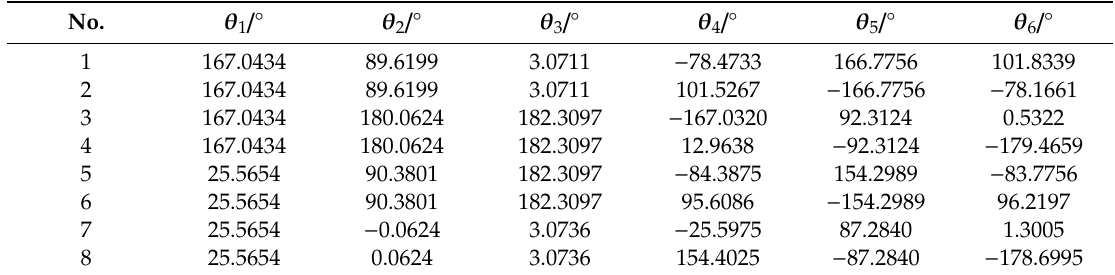
Table 18. Eight inversely solved joint angle sets by the Robotics Toolbox.